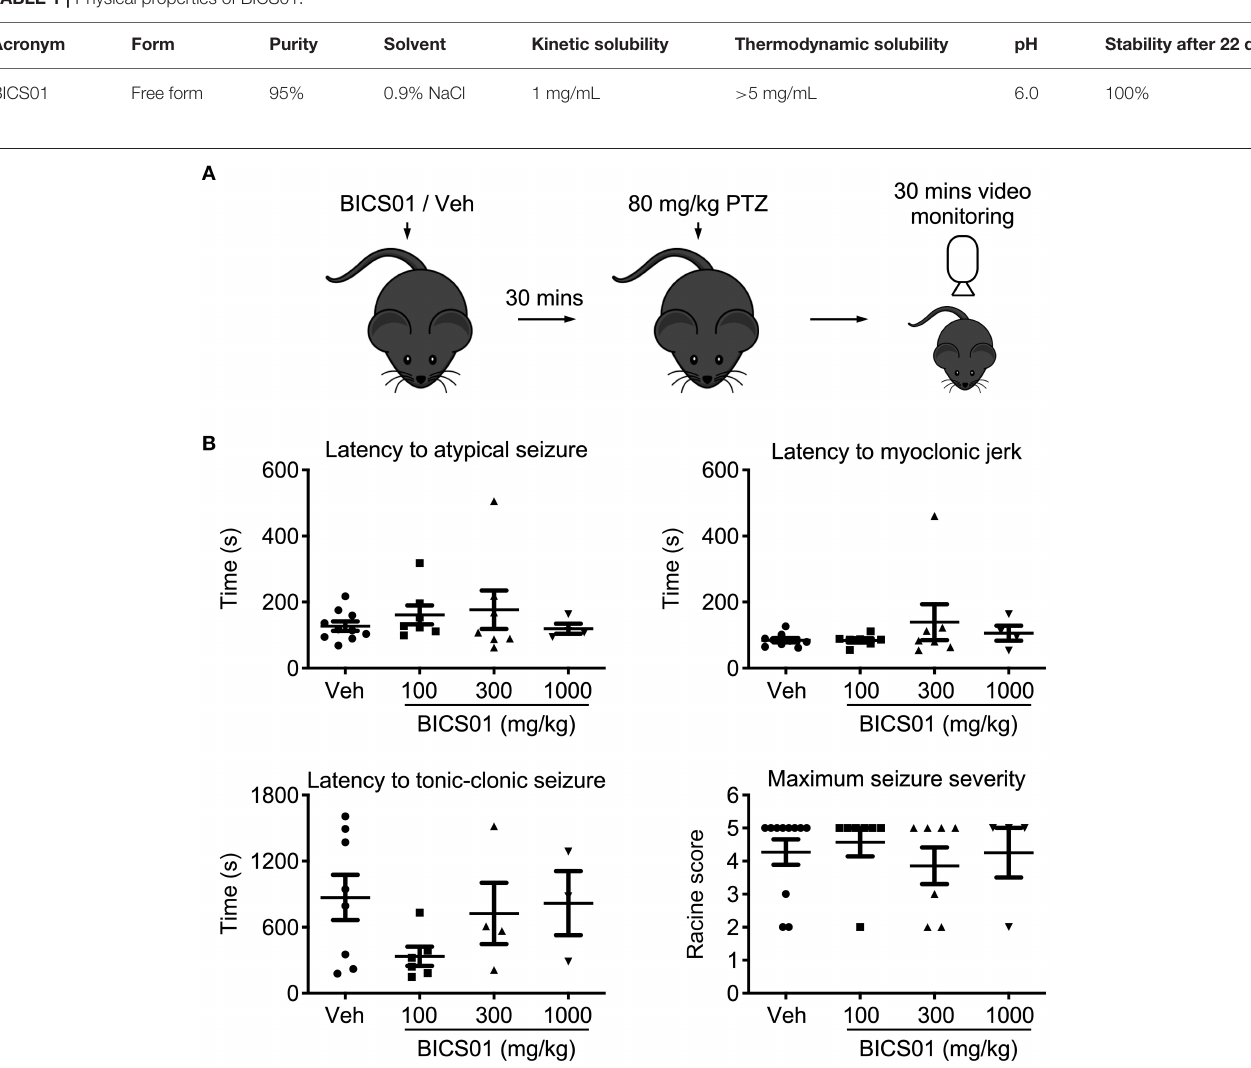
TABLE 1 | Physical properties of BICS01.